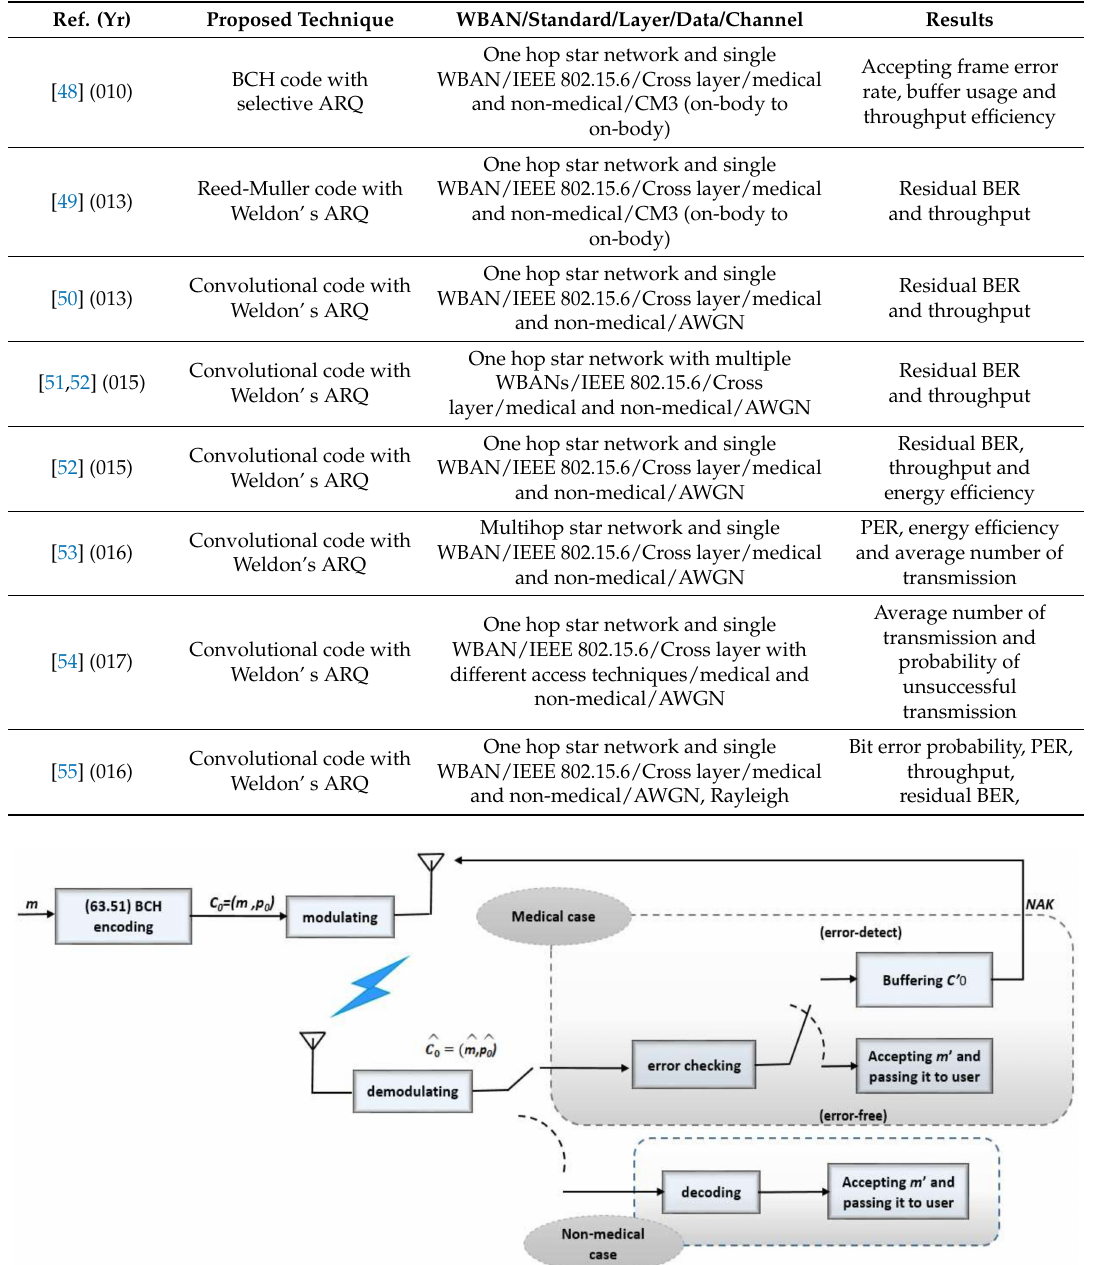
Figure 7. Hybrid automatic repeat request-II (ARQ-II)